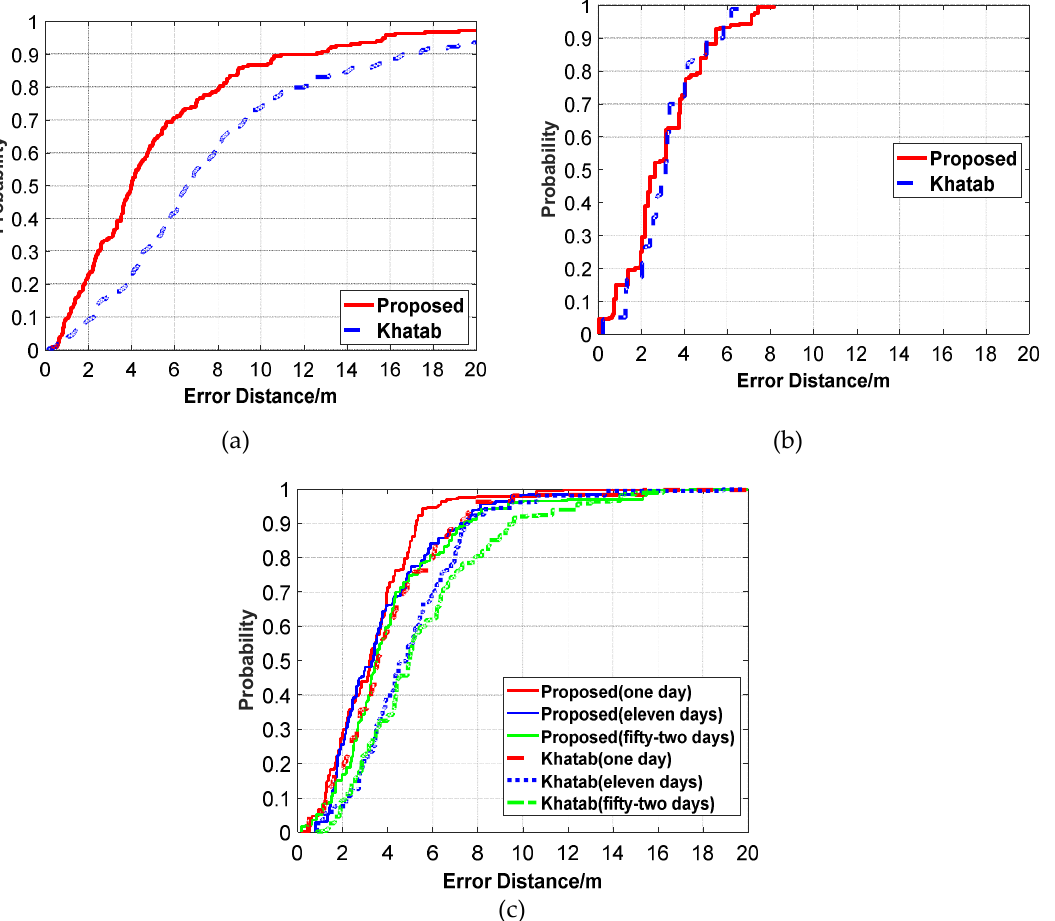
Figure 24. The positioning error comparison between our proposed algorithm and Khatab’s method on three different datasets. ( a ) Dataset1. ( b ) Dataset2. ( c ) Dataset3. Table 7. The average positioning errors between our proposed algorithm and Khatab’s method.